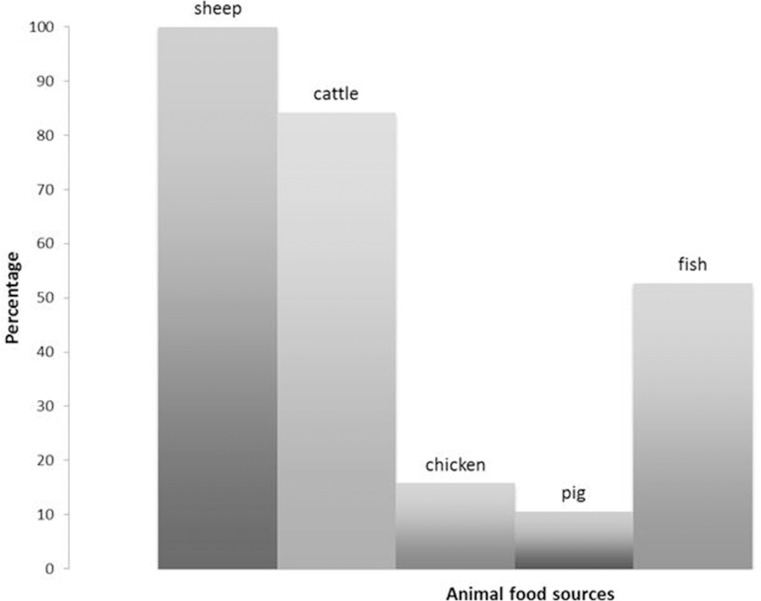
Percentages of consumption of the different animal dietary resources.